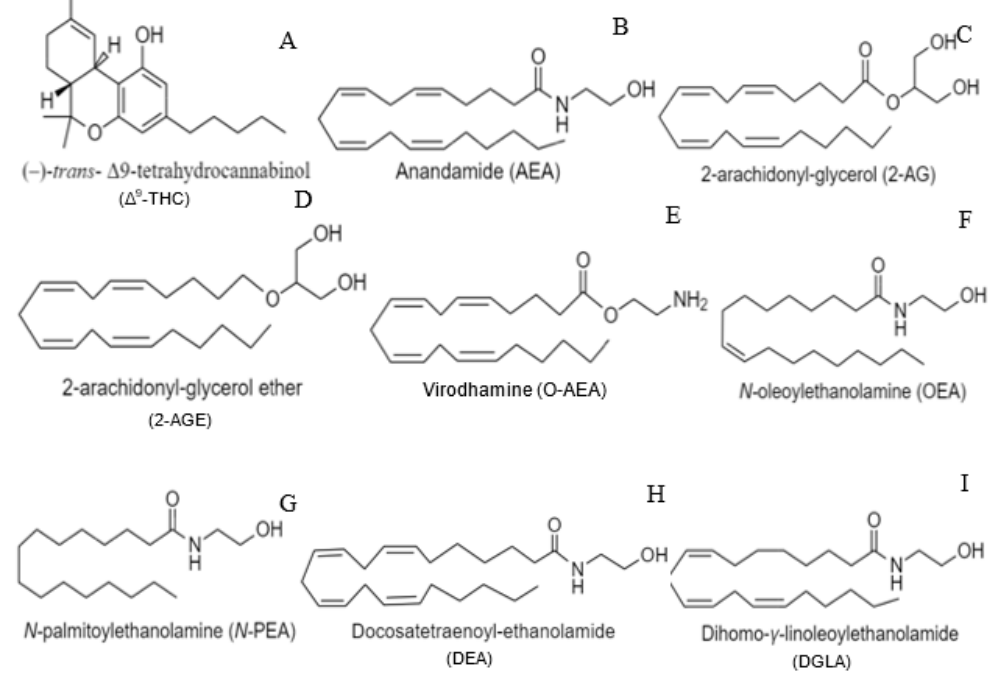
Figure 1. Chemical structures of various cannabinoid ligands. ( A ) Phytocannabinoid, THC. ( B , C ) Endocannabinoids, AEA and 2-AG. ( D – I ) Synthetic cannabinoids, 2-AGE, O-AEA, OEA, N -PEA, DEA, and DGLA.